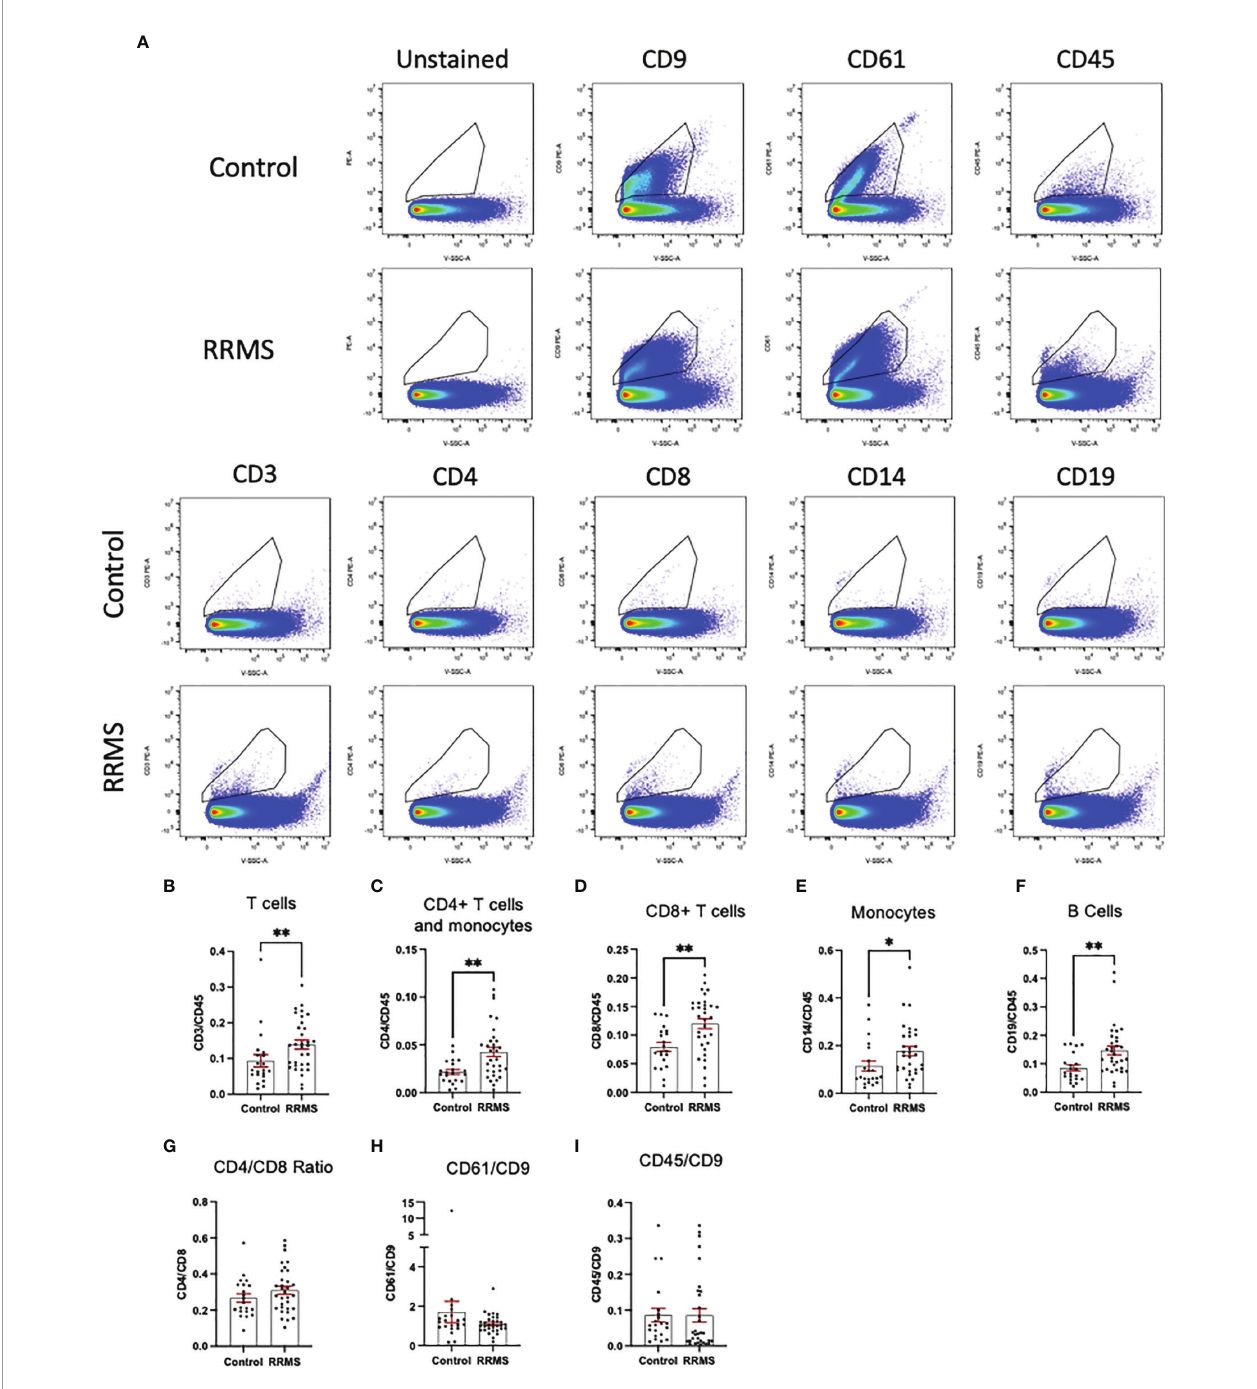
FIGURE 3 | Comparison between RRMS and Control plasma reveals increased lymphocyte-derived EVs. (A) Representative fl ow cytometry plots displaying PE+ staining in plasma from control and RRMS cases. (B-I) Analysis of lymphocyte subsets normalized to CD45+ counts reveals signi fi cantly higher amounts of CD3+, CD4+, CD8+, CD14+ and CD19+ populations in RRMS compared to healthy controls. *p < 0.05 and **p < displaying immune cell-speci fi c markers of T cells (both cytotoxic and helper), monocytes, and B cells ( Figures 3C – F ).